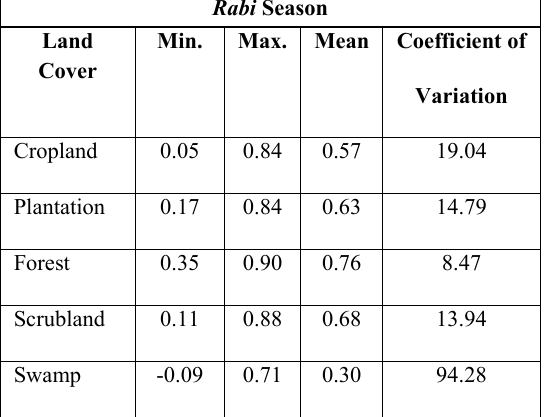
Table 3. Zonal Averaged NDVI of Land Covers in Tamil Nadu during the Rabi season of 2017